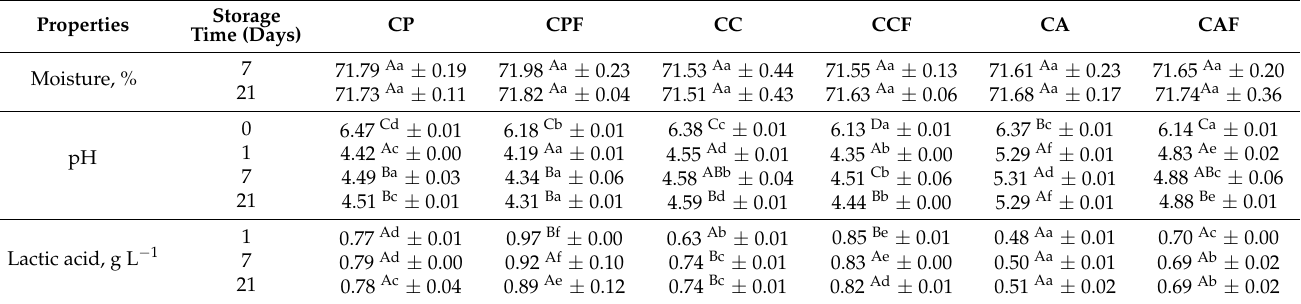
Table 2. Lactic acid content, pH value and moisture of ice cream mixes and ice creams during storage.